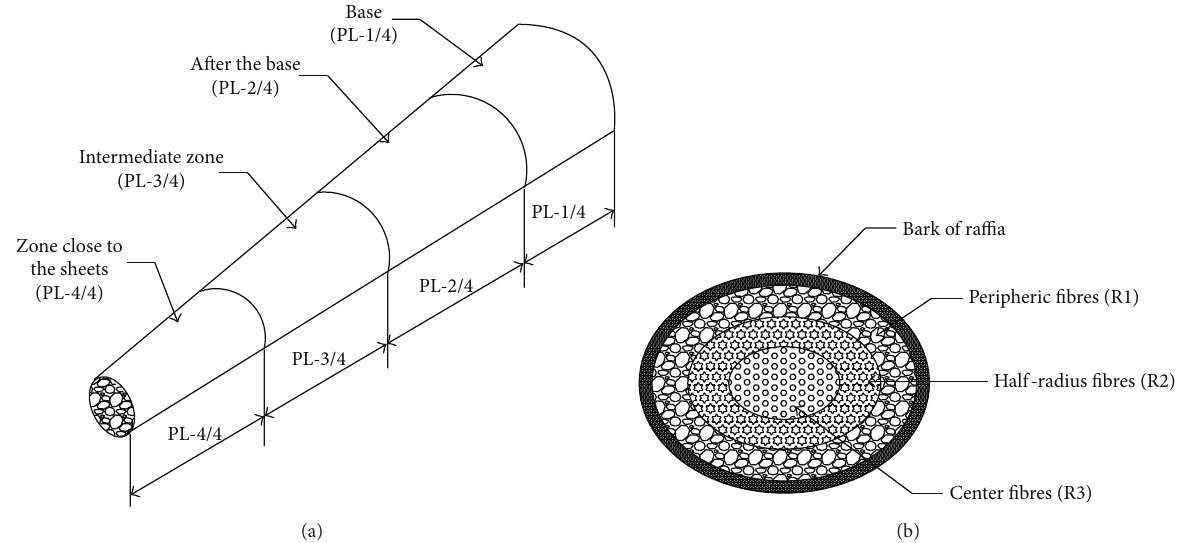
Figure 1: Localization of the zones of sampling of fibres along the stem of Raffia vinifera . (a) Longitudinal position, (b) cross section according to a precise longitudinal